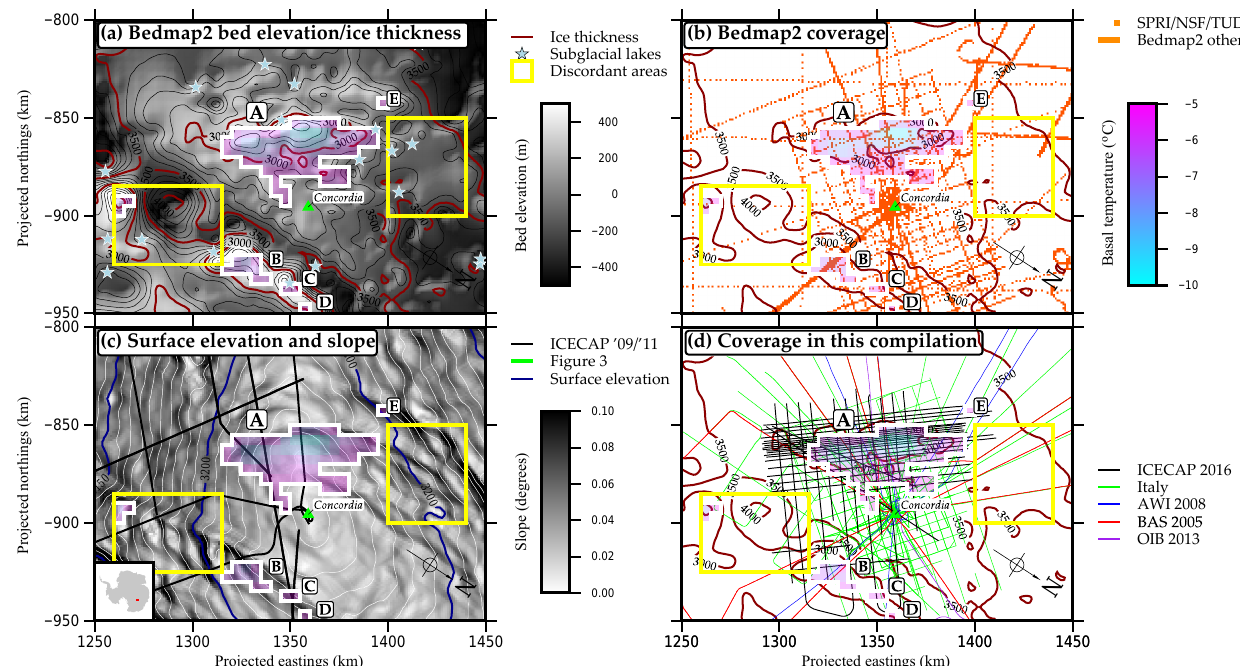
Figure 2. Dome C in the context of the Van Liefferinge and Pattyn (2013) frozen bed candidates and Concordia Station. A threshold of − 5 ◦ C was used for selecting candidates. Bedmap2 bed elevation and ice thickness contours (Fretwell et al., 2013) are shown in (a) , along with subglacial lakes known as of Wright and Siegert (2012). Regions where trends seen in surface data are absent in Bedmap2 are shown by the yellow boxes in all panels. Coverage used to constrain Bedmap2 (orange) is shown in (b) , with the 1970s SPRI/NSF/TUD data set being the sparse, dotted lines. Surface elevation and slope from Cryosat-2 (Helm et al., 2014) is shown in (c) , with older ICECAP tracks (Cavitte et al., 2016) in black and a green line showing the ice divide profile shown in Fig. 3. ICECAP Old Ice A data discussed in this paper (black), as well additional modern data sets are shown in (d) . Contours in (c) and (d) are Bedmap2 ice thickness. Projection is Antarctic Polar Stereographic, and the region corresponds to the red box in Fig.